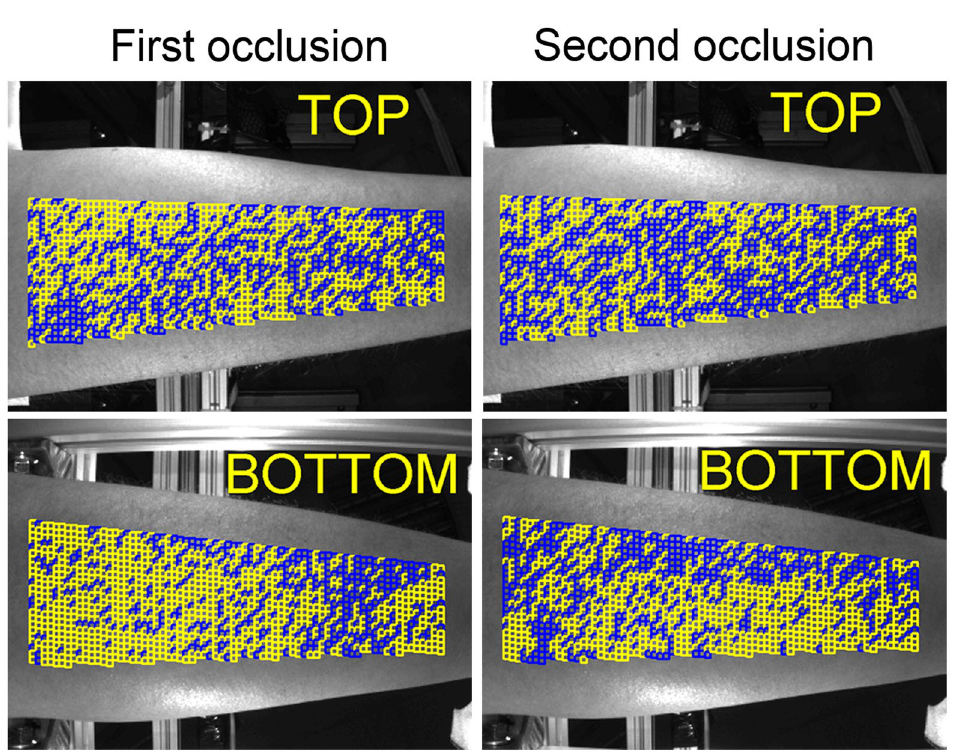
Figure 4. Mapping of the good ROIs distribution. Images in the left column calculated during the first occlusion whereas those in the right column are in the second occlusion that started 10 s later the cuff was deflated. Yellow and blue squares show ROIs with the linear and distorted PPG waveforms,